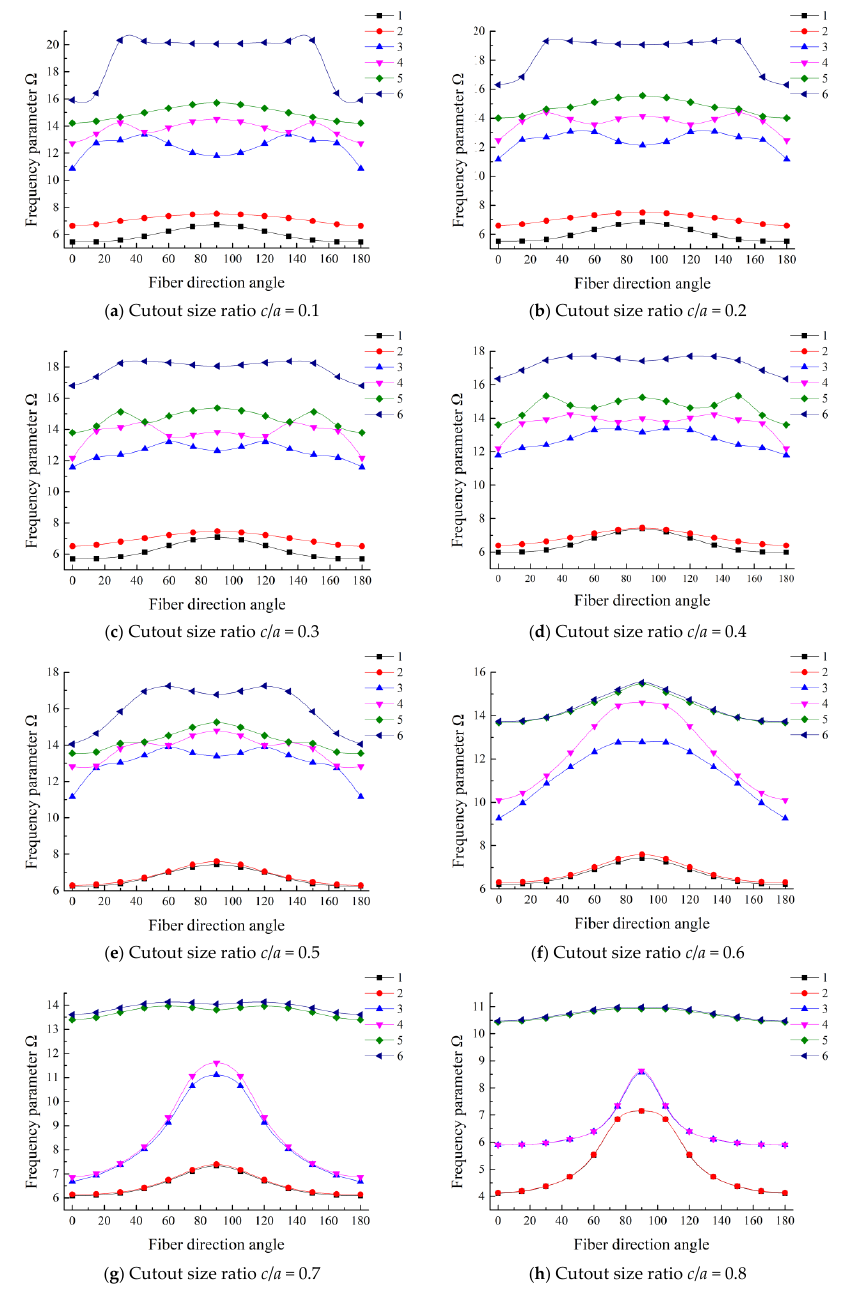
Figure 7. The first six frequency parameters of different fiber orientations with various cutout sizes.